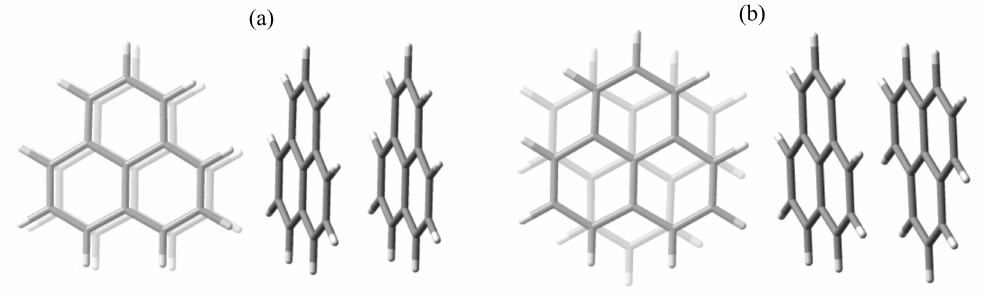
Figure 2. The top and side views of two distinct phenalenyl dimer conformations: ( a ) eclipsed and ( b )